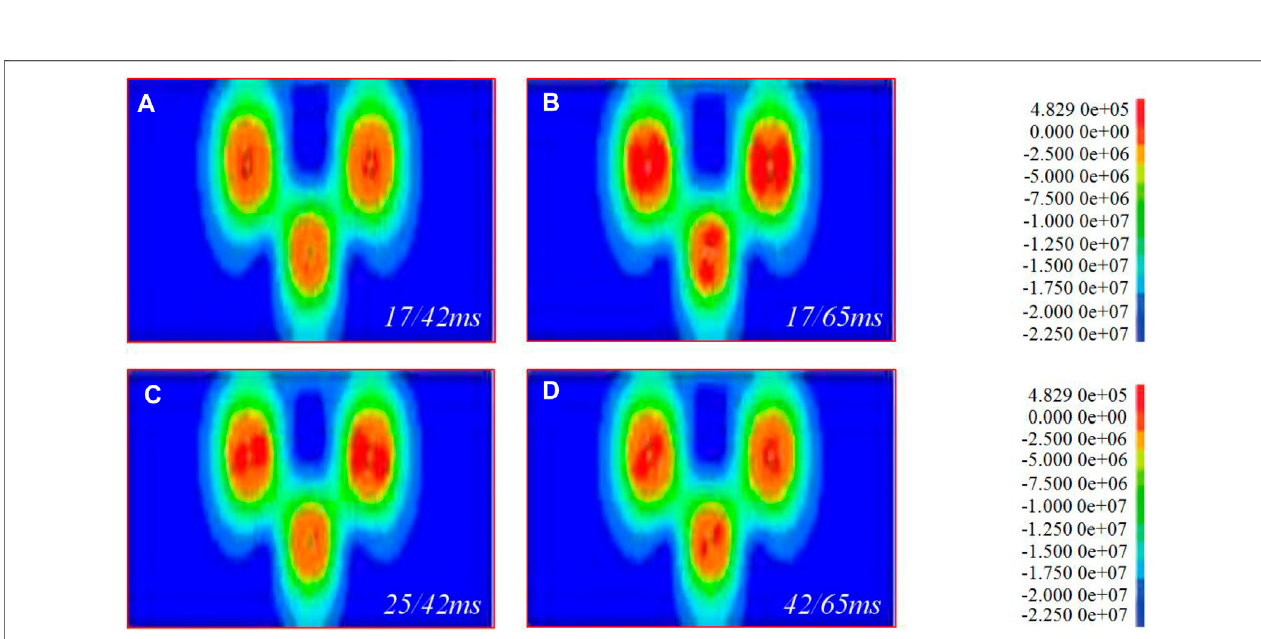
platform on the east side of the Jianshan slope. During the mining blasting process, more than 20 vibration monitoring tasks were carried out. Among them, several groups of data measured on high slopes are selected for comparison and